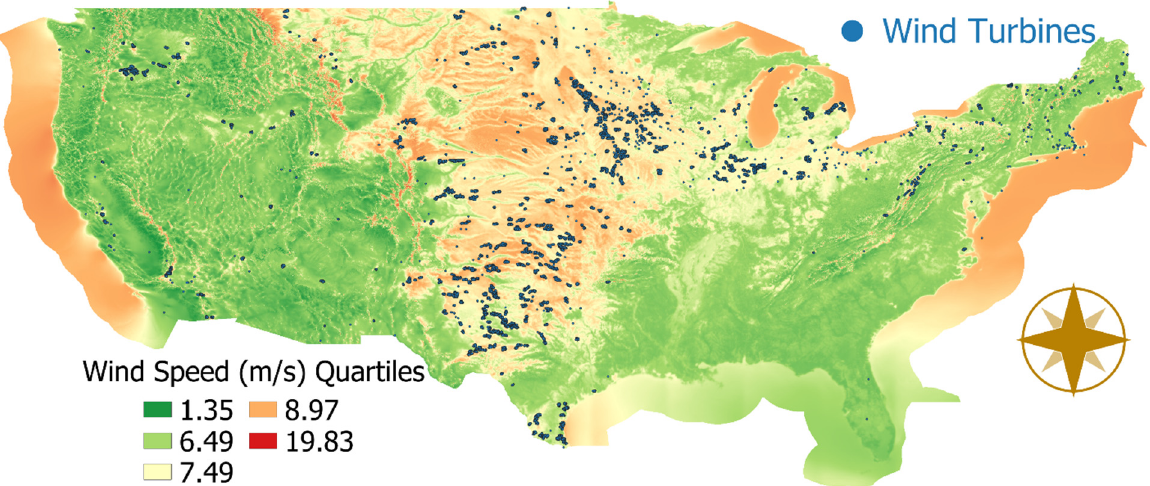
Figure 2. Wind speeds classified by quartiles in the continental U.S. at a 100 m height overlaid with wind turbines from the USWTDB.